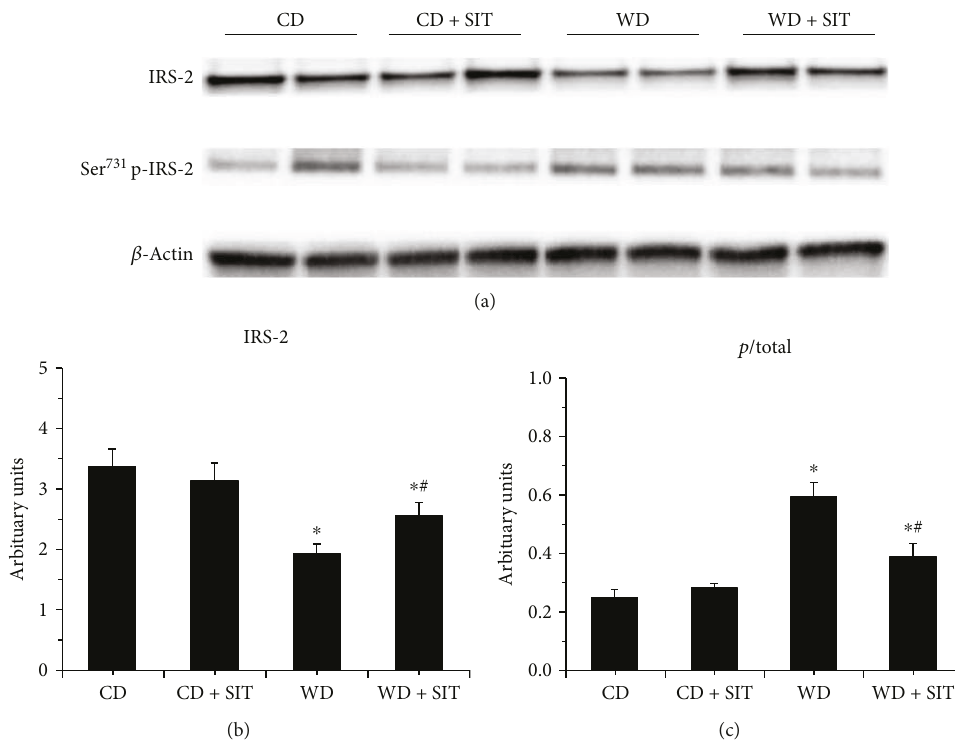
Figure 5: Western blot analysis of phosphorylated ( p ) and total IRS-1 in pancreas tissue at the end of experiment, total IRS-1 decreased, and Ser phosphorylation of IRS-2 increased in WD mice. SIT treatment reduced both the total IRS-2 signi fi cantly and the ratio of p /total. ∗ P < 0 05 compared to the CD group; # P < 0 05 compared to the WD